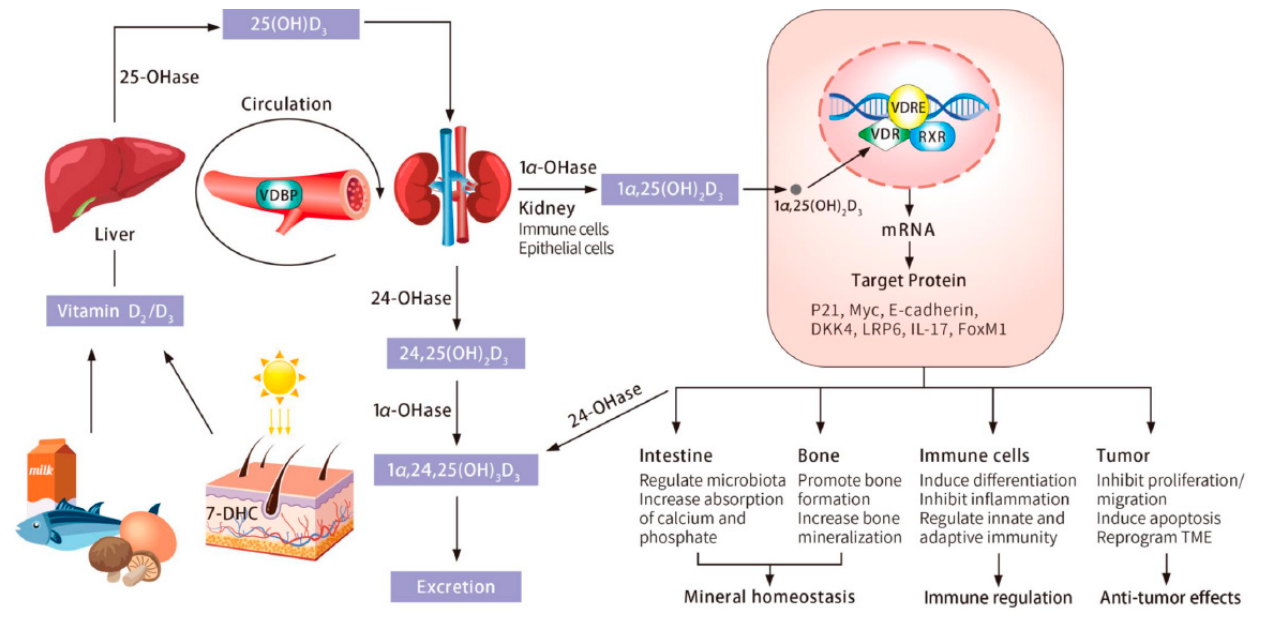
Figure 1. Vitamin D metabolism and biological functions. Vitamin D is obtained either from precursors in food or produced in the skin from conversion of 7-DHC through sunlight exposure. In the liver, vitamin D 3 is hydroxylated to form 25(OH)D 3 . A second hydroxylation produces the active metabolite 1 ⍺ ,25(OH) 2 D 3 . This step mainly takes place in the kidney but also in other tissues, such as immune cells and epithelial cells expressing 1 ⍺ -hydroxylase. Vitamin D metabolites are carried by VDBP in the blood circulation. 1 ⍺ ,25(OH) 2 D 3 enters cells and binds to VDR, which enables the formation of VDR-RXR complex. This complex translocates into cell nuclei and binds to VDRE to regulate gene expression. Vitamin D has various biological functions in multiple organs and tissues. Active forms of vitamin D are degraded in the kidney as well as other target tissues and finally excreted by urine. 7DHC, 7-dehydrocholesterol; VDBP, vitamin D binding protein; VDR, vitamin D receptor; RXR, retinoid X receptor; VDRE, vitamin D response element.